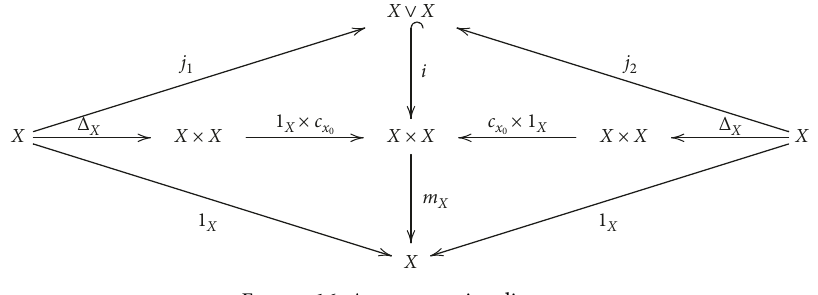
Figure 16: A commutative diagram.